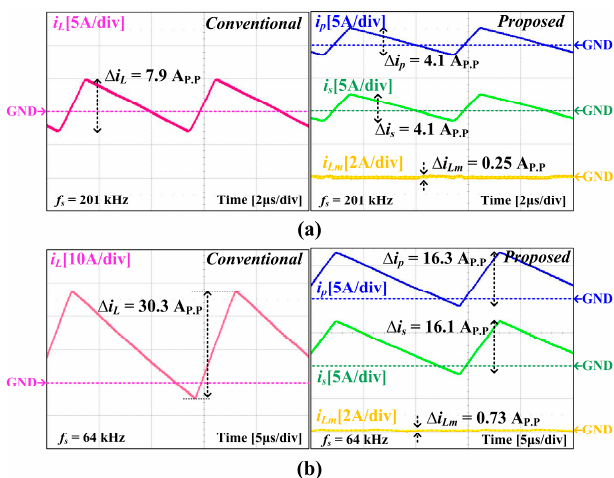
Figure 13. Waveforms for W.